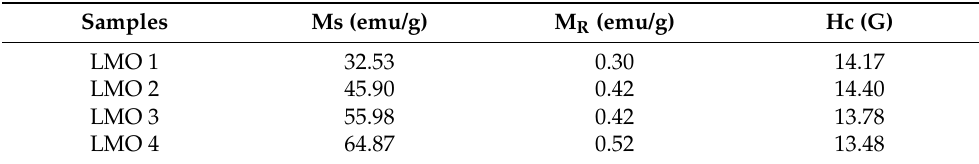
Table 8. Magnetic properties of MREs for different ratios of LMO:AO.